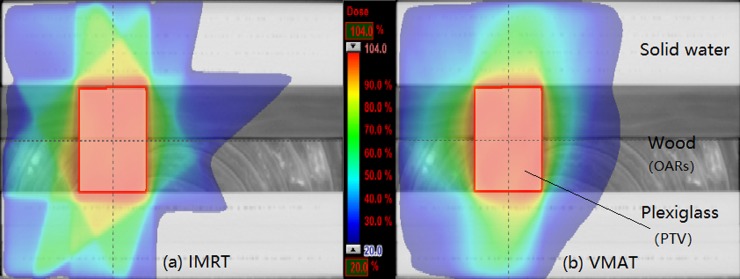
The dose distributions for the (a) IMRT and (b) VMAT plans.